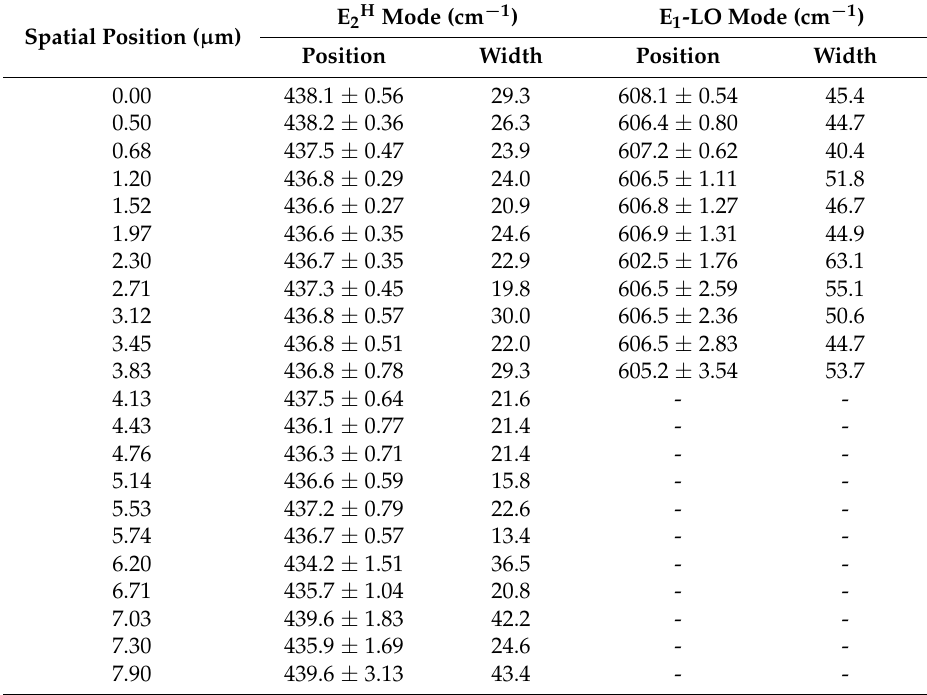
Table 1. Summary of the fitting parameters of each phonon vibration mode along the growth direction of a single ZnO